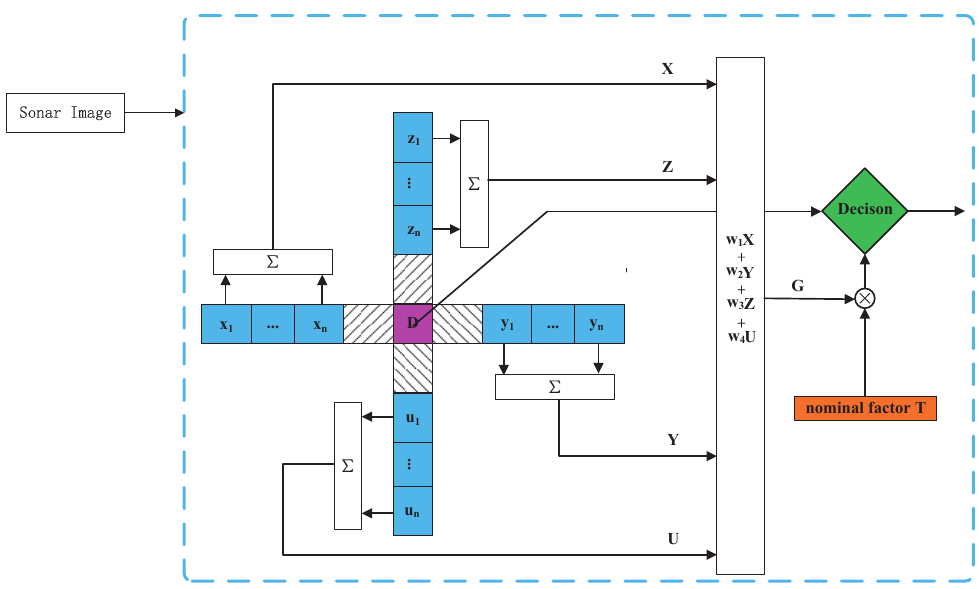
Figure 3. The basic 2D-CFAR model